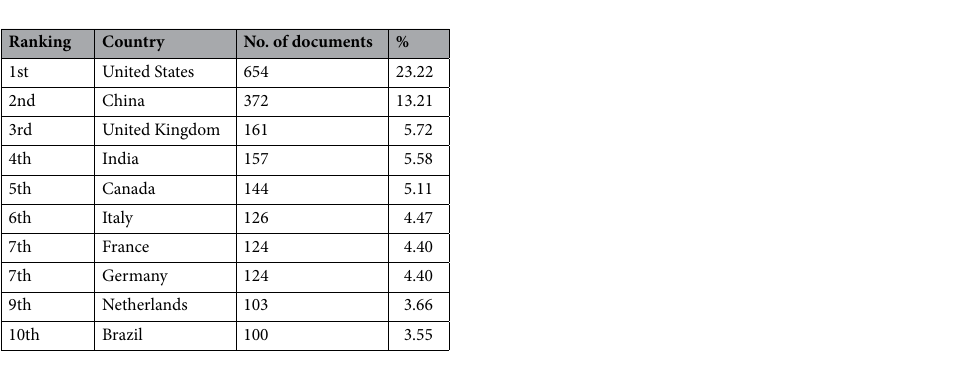
Table 1. Top ten active countries in research related to the links between the microbiota and antibiotics from 2002 to 2021.